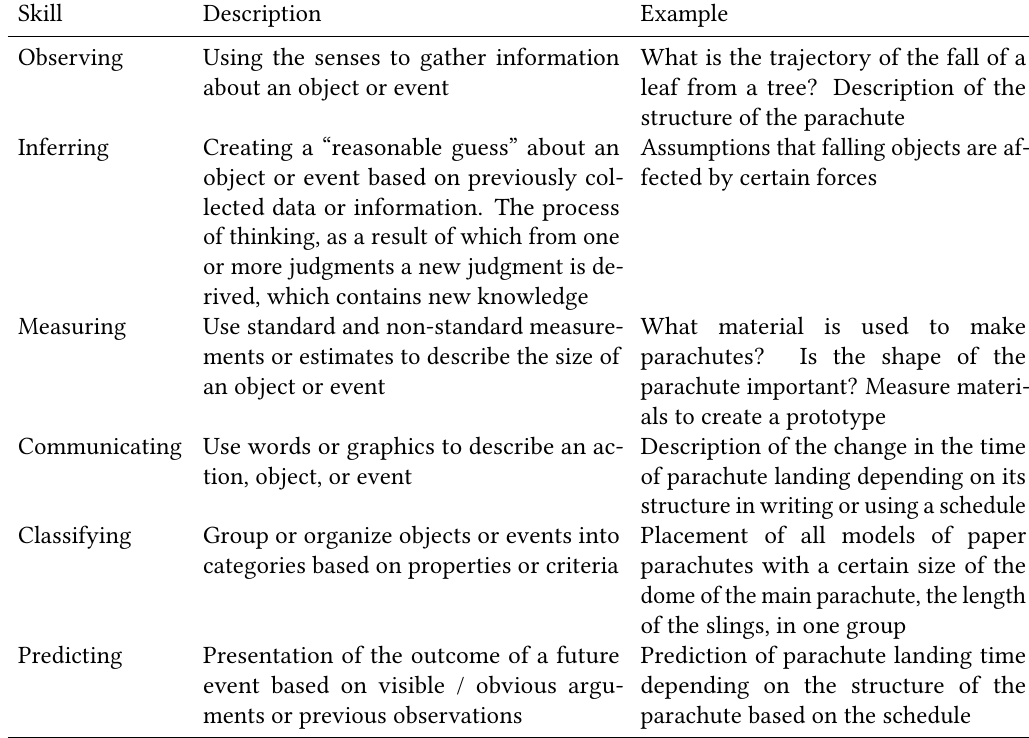
Table 2 Basic skills in organizing scientific